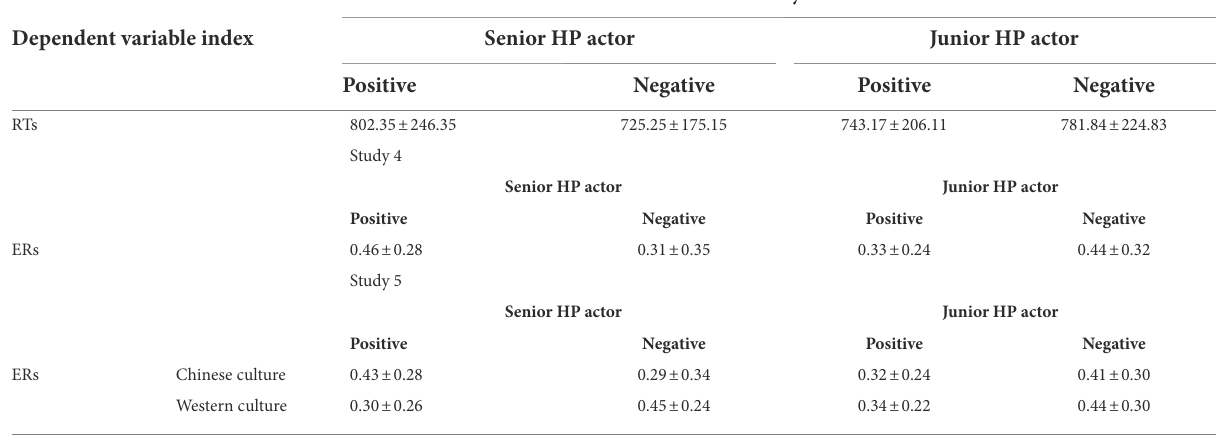
TABLE 3 Participants’ mean value and standard deviation in each condition across Study 3, 4 and 5 ( M ±